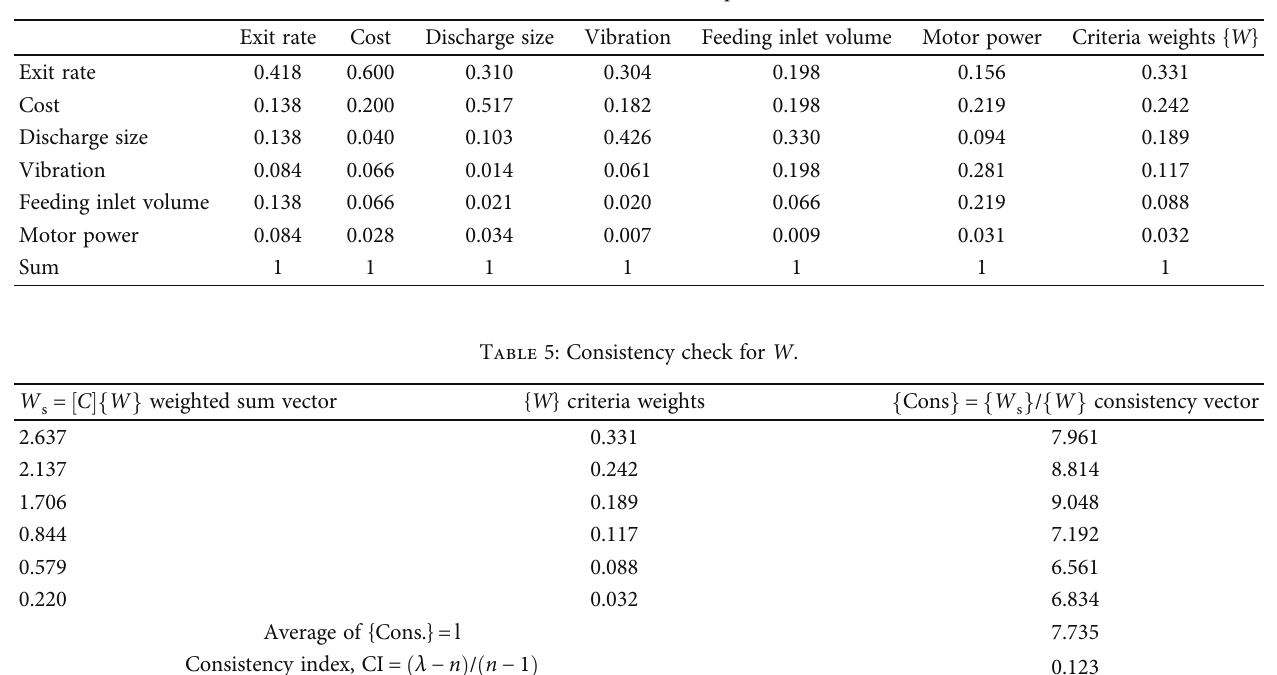
Table 4: Normalized criteria comparison matrix.